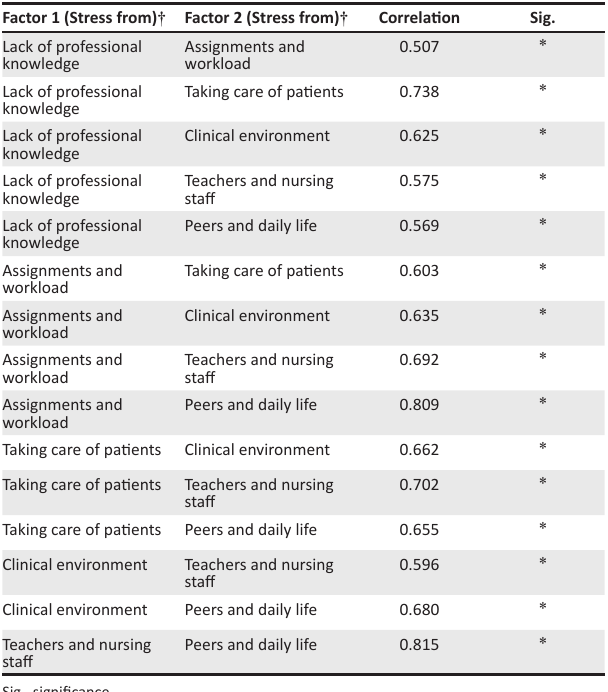
TABLE 6: Latent factor correlations. Factor 1 (Stress from) † Factor 2 (Stress from) † Correlation